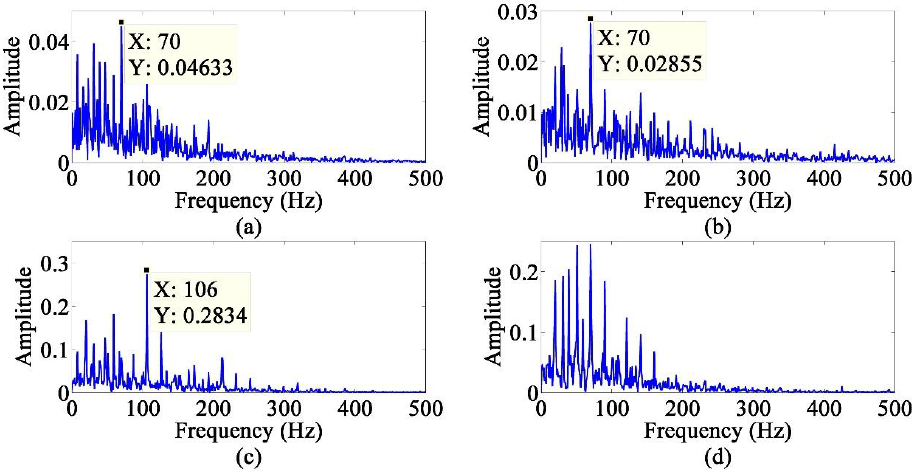
Figure 13. The Hilbert envelope spectra of each component signal after VMD. ( a ) Component signal 1. ( b ) Component signal 2. ( c ) Component signal 3. ( d ) Component signal 4.